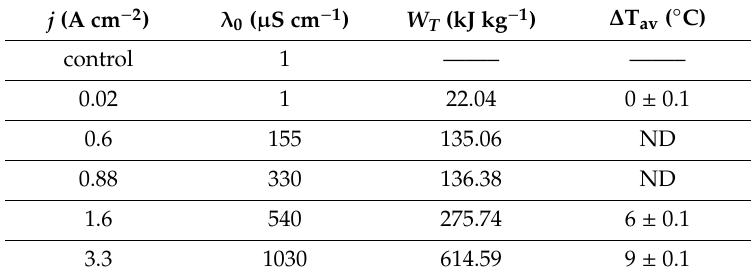
Table 1. Measured and calculated values as a function of PEF treatment in di ff erent media with S.